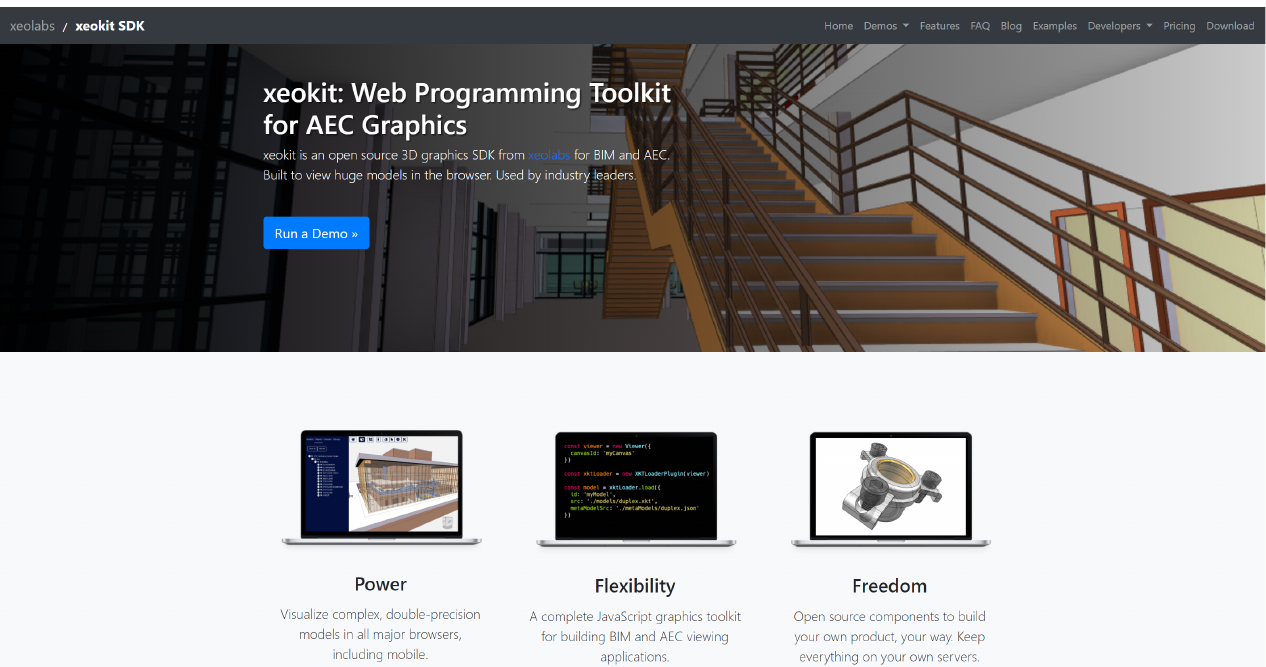
Figure 4. XEOKIT website: homepage with descriptions of functionalities.